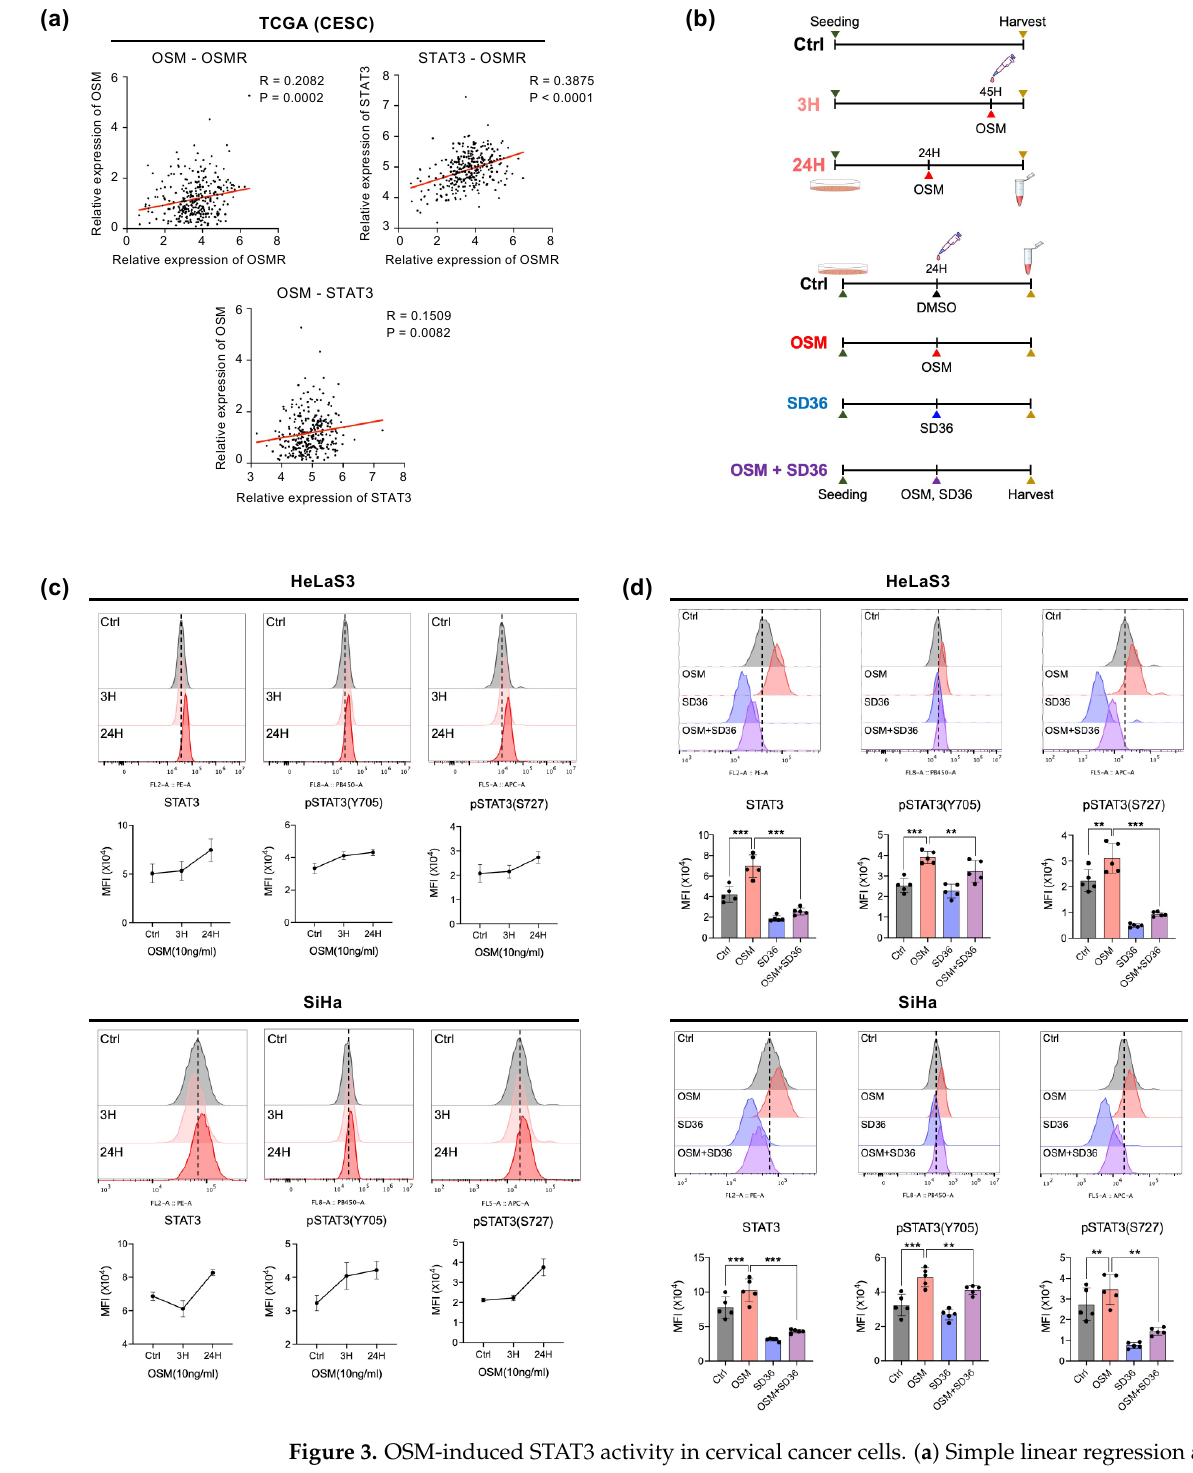
Figure 3. OSM-induced STAT3 activity in cervical cancer cells. ( a ) Simple linear regression analysis of expression levels of OSM , OSMR , and STAT3 in CESC from TCGA (n = 306). ( b ) Experimental design: Upper panel; HelaS3 and SiHa were exposed to OSM (10ng/mL) for 3 or 24 h. Lower panel; HeLaS3 and SiHa underwent one of four different combinations of OSM and SD-36 (1 mM/mL) for 24 h. ( c ) Analysis of STAT3 and pSTAT3 (Y705, S727) protein expression by flow cytometry in HeLaS3 and SiHa during the time course of OSM stimulation (10 ng/mL) as indicated (Data are presented as mean ± standard error (SEM)). ( d ) Analysis of STAT3 and pSTAT3 (Y705, S727) expression by flow cytometry among four conditions; ** p < 0.01, *** p < 0.001; Paired t-test.